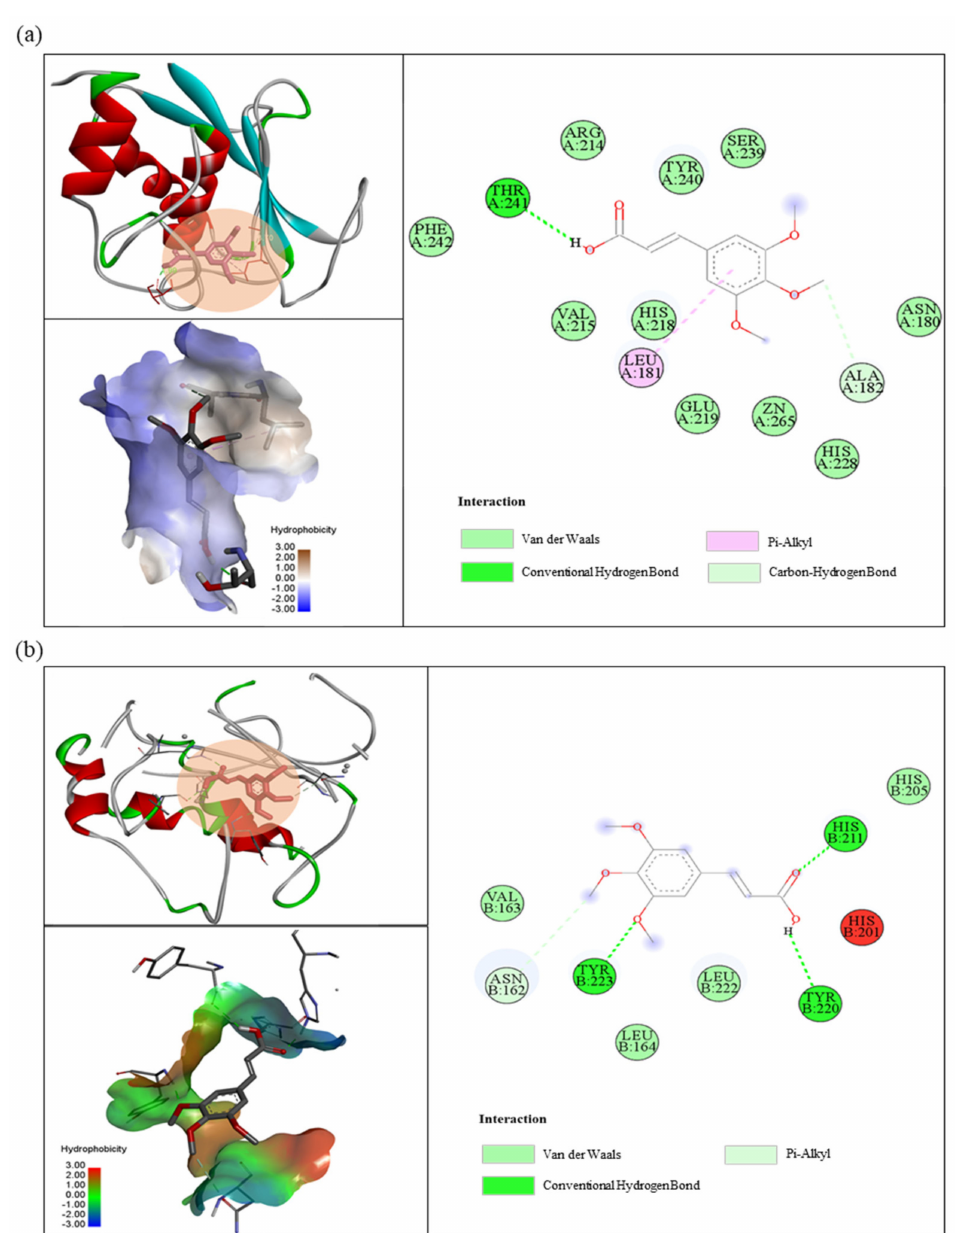
Figure 5. Molecular interaction of 3,4,5-trimethoxycinnamic acid with ( a ) MMP-1 and ( b ) MMP-3. The figure was built using PyMOL and Discovery